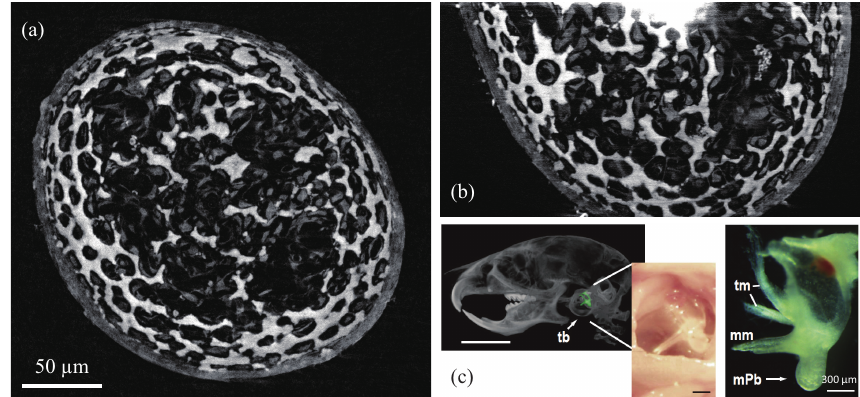
Figure 9. Phase tomogram of a removed malleal processus brevis (mPb) from a mouse nine days after birth [71]: ( a ) Axial view, ( b ) meridian view, ( c ) location of the sample in a body (X-ray and optical pictures) [72].